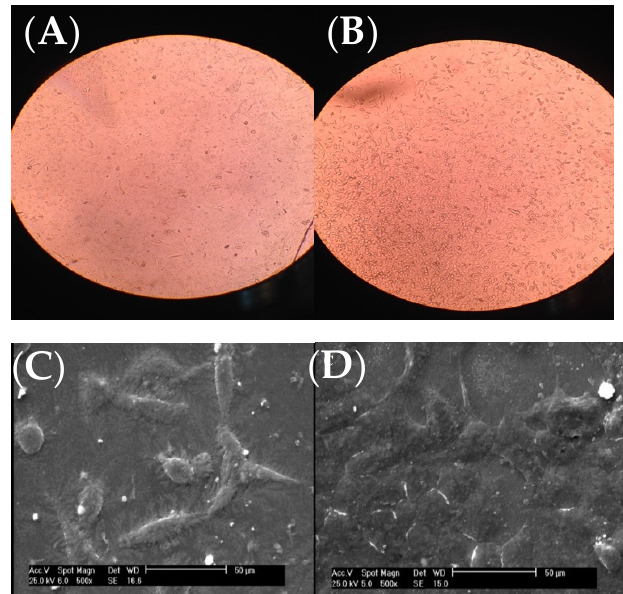
Figure 4. Images of fibroblast cells on gelatin films, ( A ) inverted optical microscope image from the untreated gelatin film, ( B ) inverted optical microscope image from the atmospheric-air plasma-treated gelatin film, ( C ) SEM image from the untreated gelatin film, ( D ) SEM image from the atmospheric-air plasma-treated gelatin film.